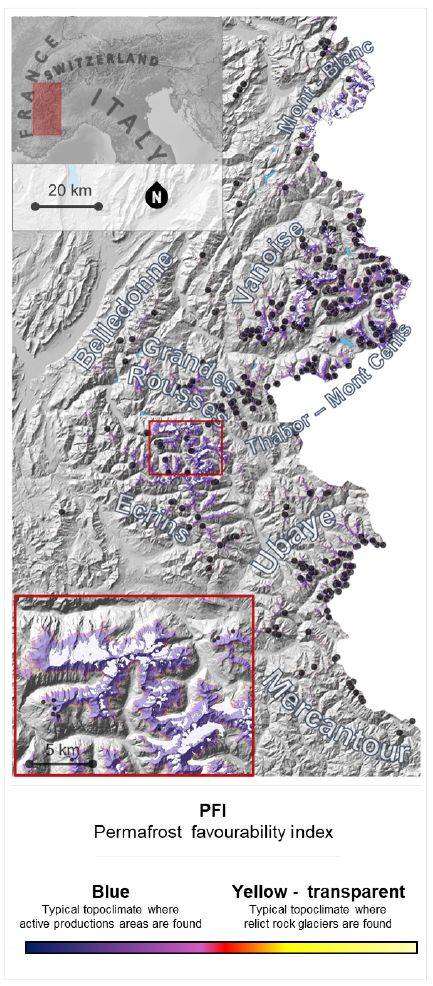
Figure 1. Identification of the study area in the European Alps and overview of the periglacial environment. Permafrost distribution is represented by the PFI map (Marcer et al., 2017). Black dots iden- tify active rock glacier locations (Marcer et al.,